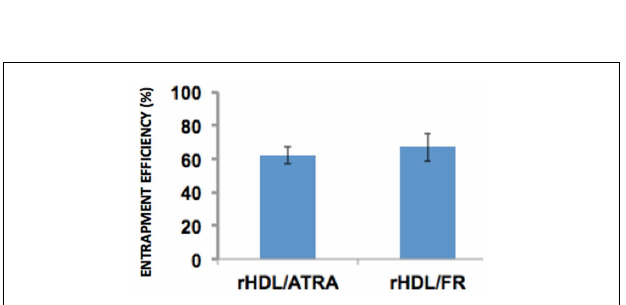
FIGURE 2 | Chemical composition of rHDL/ATRA and rHDL/FR particles.